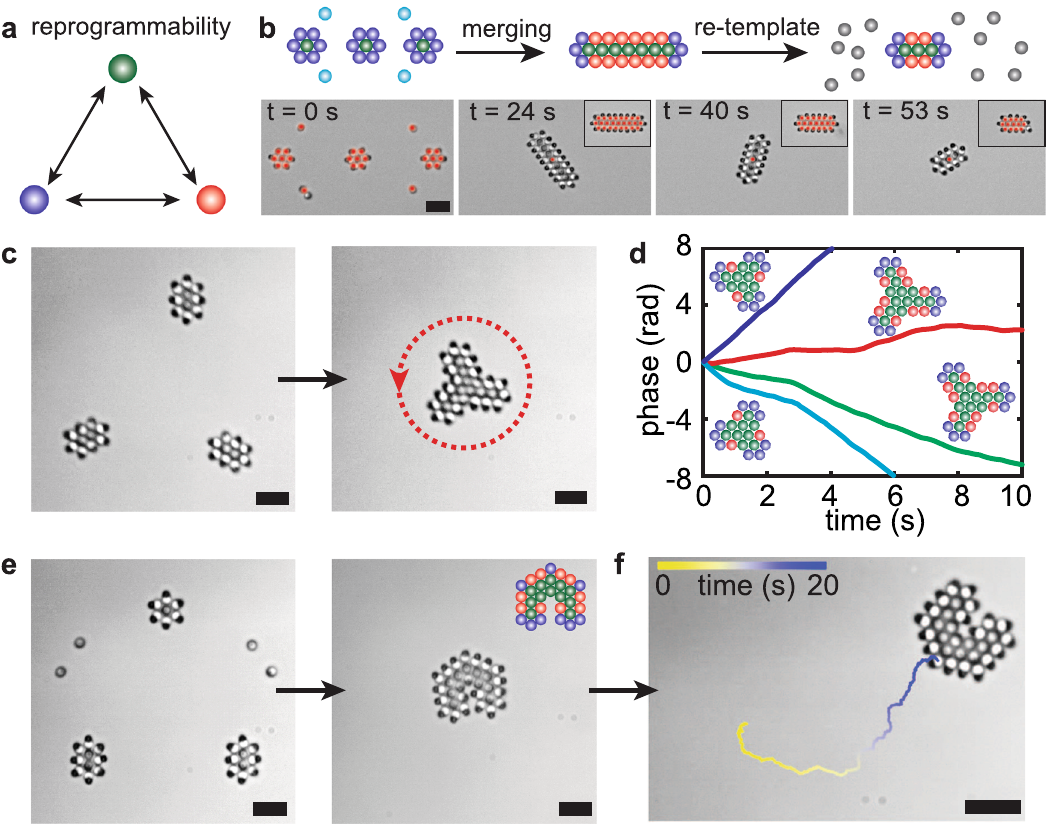
Fig. 4 Reprogrammable metamachines. a Heterodimers reprogram autonomously and change functionality (colors as in Fig. 3a). b Metamachine recon fi guration. Top: schematic of the recon fi guration process. Colors indicate the functions as de fi ned in Fig. 3a. They highlight the autonomous reprogramming of the particles as the structure recon fi gures. Substructures are templated then merged to build a slender metamachine. Changes in templates lead to recon fi guration of the machine enabled by the autonomous reprogrammation of the constitutive particles. Bottom: experiment time- lapse. Red circles indicate optical traps, used for re-templating and practical pinning of the structure. Insets: optical patterns for re-templating. c Formation of chiral structures by template-and-merge. The dashed arrow indicates the direction of rotation. d Rotational dynamics of 4 different chiral structures with diagrams highlighting the role of red ( n = 4) swimmers to set the chirality. e Assembly of a translational metamachine by template and merge. The diagram highlights the role of green ( n = 5) swimmers at the concave angle to introduce the forward/backward asymmetry and persistent self-propulsion of the machine, presented in ( f ). Scale bars are 5 μ